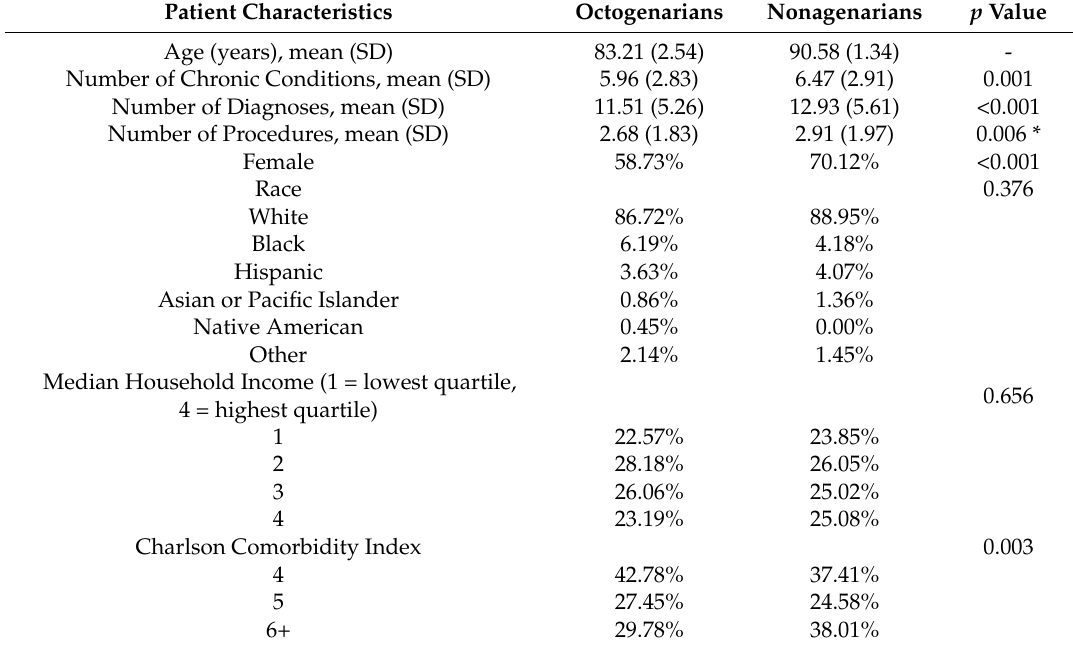
Table 3. Comparing characteristics of patients undergoing revision total knee arthroplasty between octogenarians and nonagenarians. Healthcare Cost and Utilization Project—Nationwide Inpatient Sample, 2010–2014.